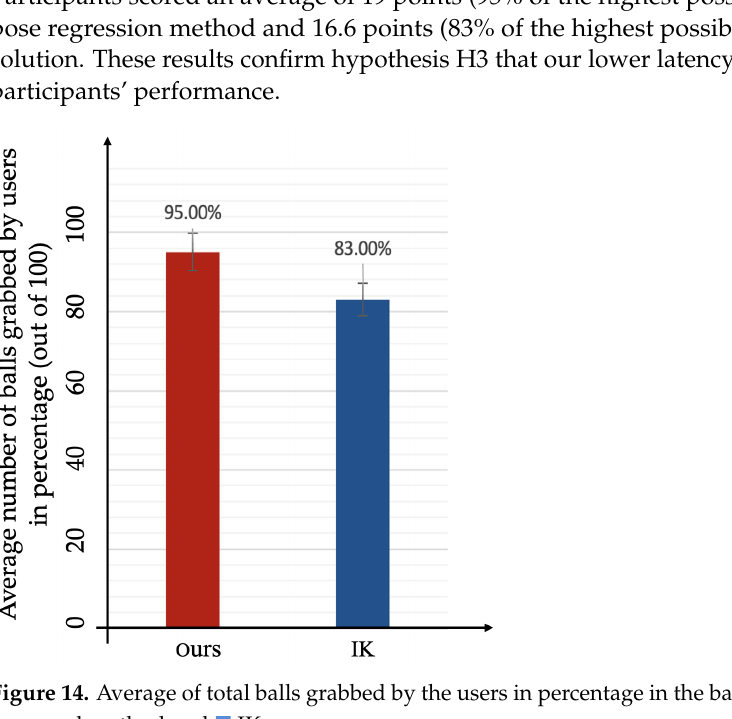
Table 9. Statistical analysis of questionnaire of the archery game under our method and the IK method . * marks the questions with insignificant differences.